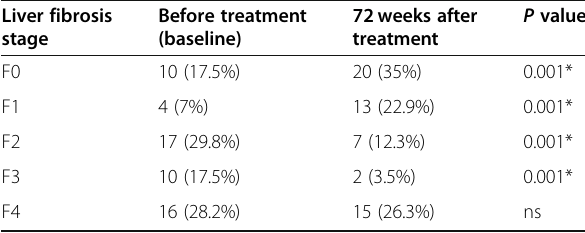
Table 4 Fibrosis stage before and 72 weeks after SMV/SOF therapy in SVR patients Liver fibrosis